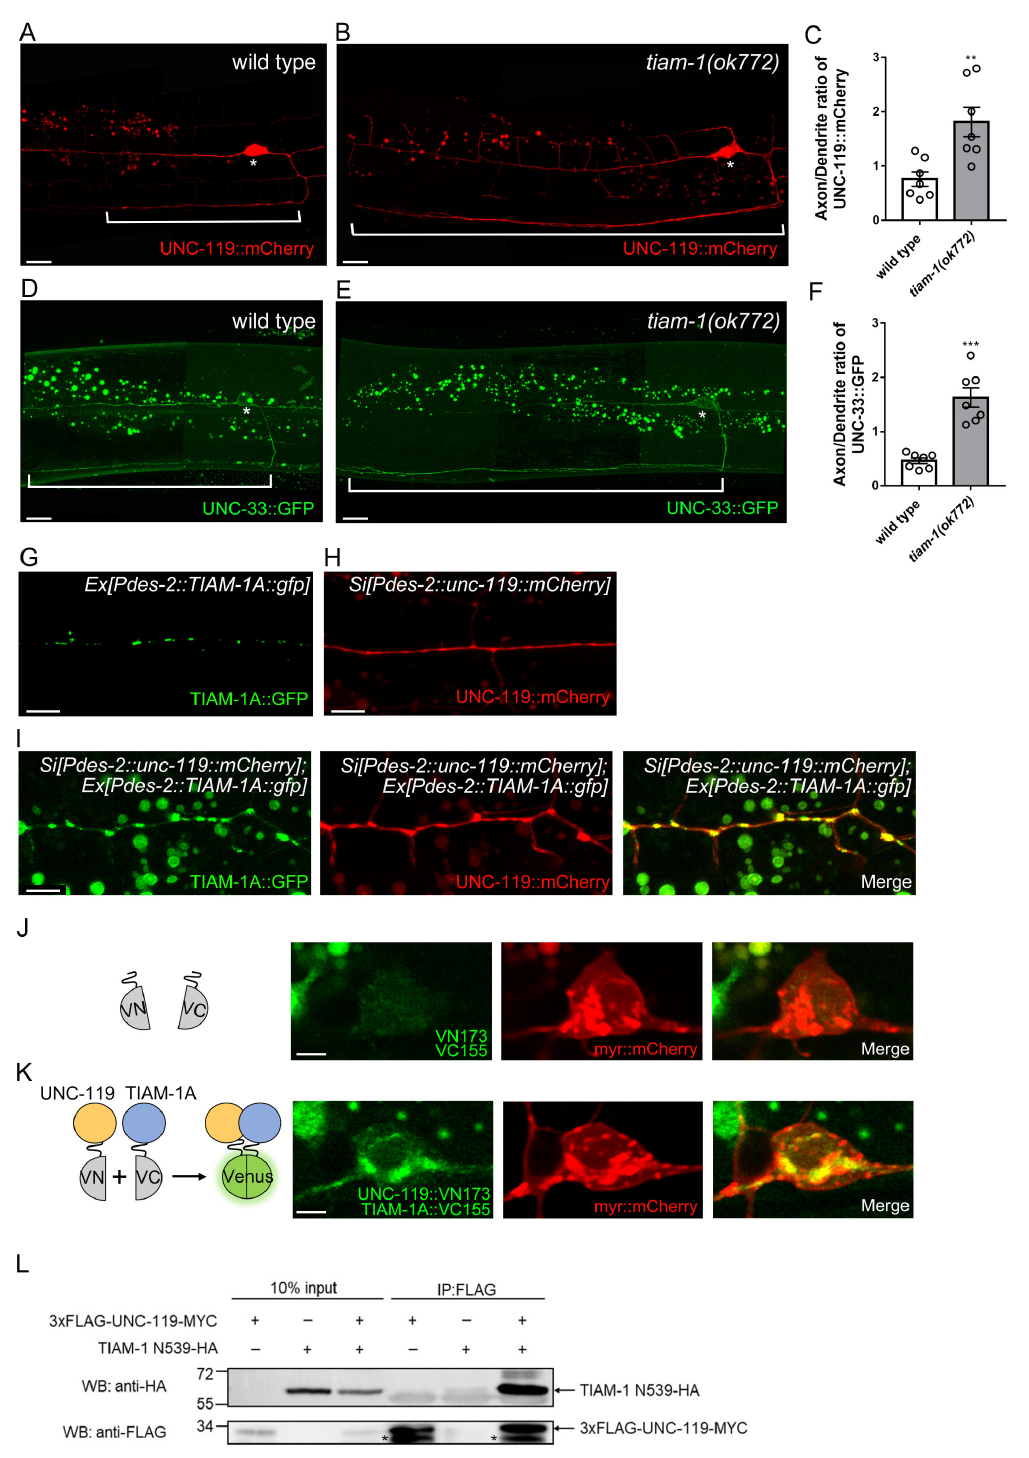
Fig 6. TIAM-1 interacts with UNC-119 and regulates the distribution of UNC-119 in PVD neurons. (A and B) UNC-119:: mCherry expressed by a single-copy transgene in PVD neuron in wild type (A) and tiam-1(ok772) (B). Brackets indicate the axon and asterisks indicate the cell body. Scale bar, 10 μ m. (C) The ratio of axonal to dendritic UNC-119::mCherry intensity. Error bar, SEM, n = 7. �� P < 0.01, Student’s t -test, compared to wild type. (D and E) UNC-33::GFP expressed by a single-copy transgene